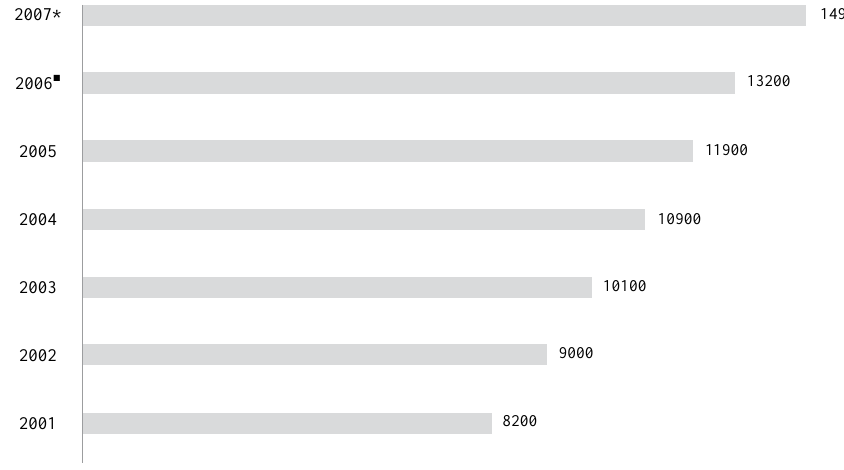
fig. 2. GDP per capita. Source: The Department of Statistics [Lithuania in Europe 2008]